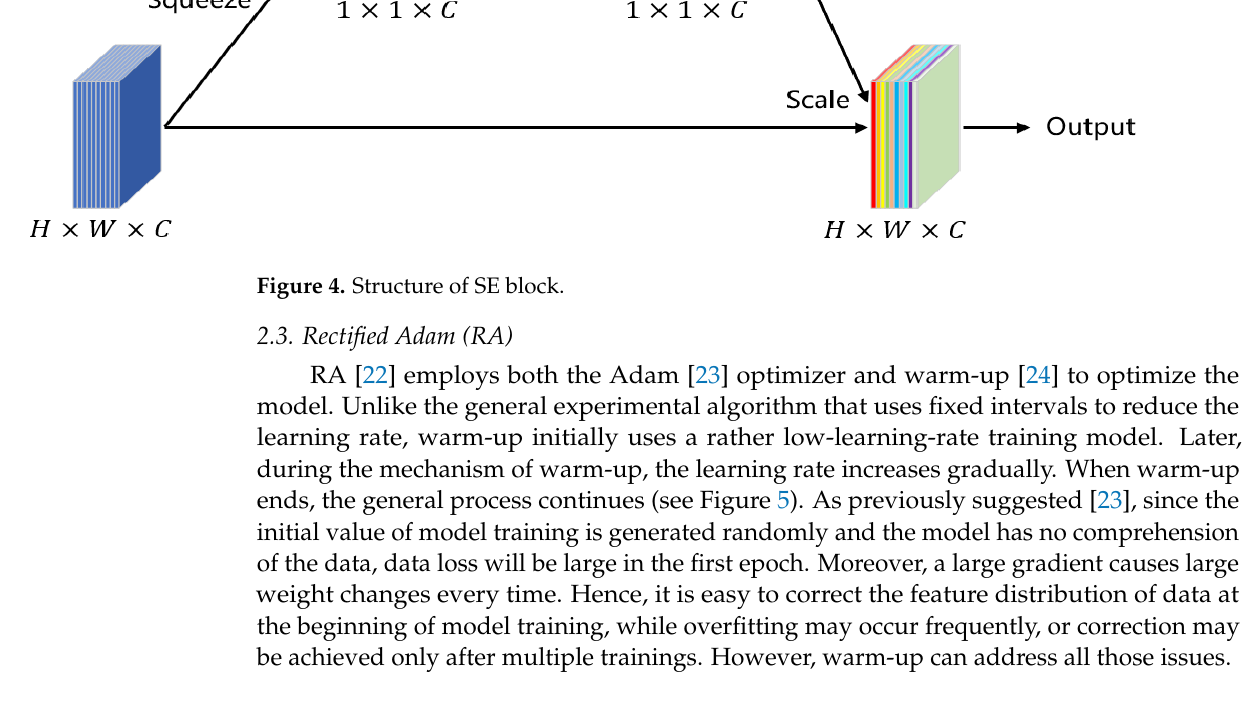
Figure 4. Structure of SE block.